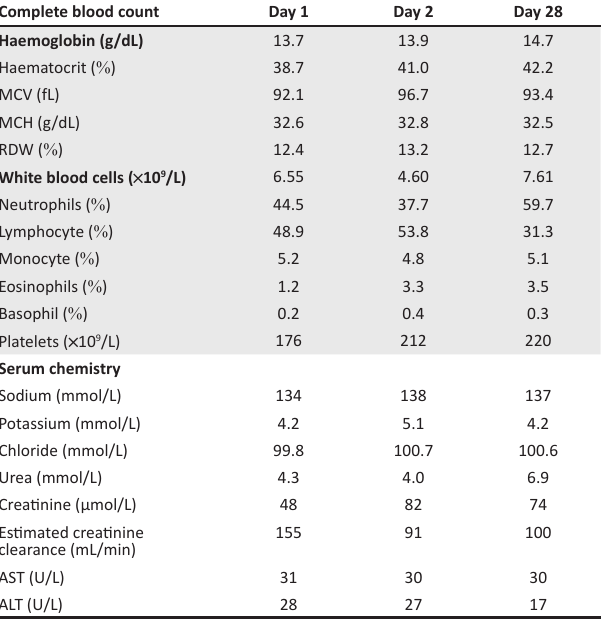
TABLE 1: Changes in full blood count and serum chemistry during admission and follow-up. Complete blood count Day